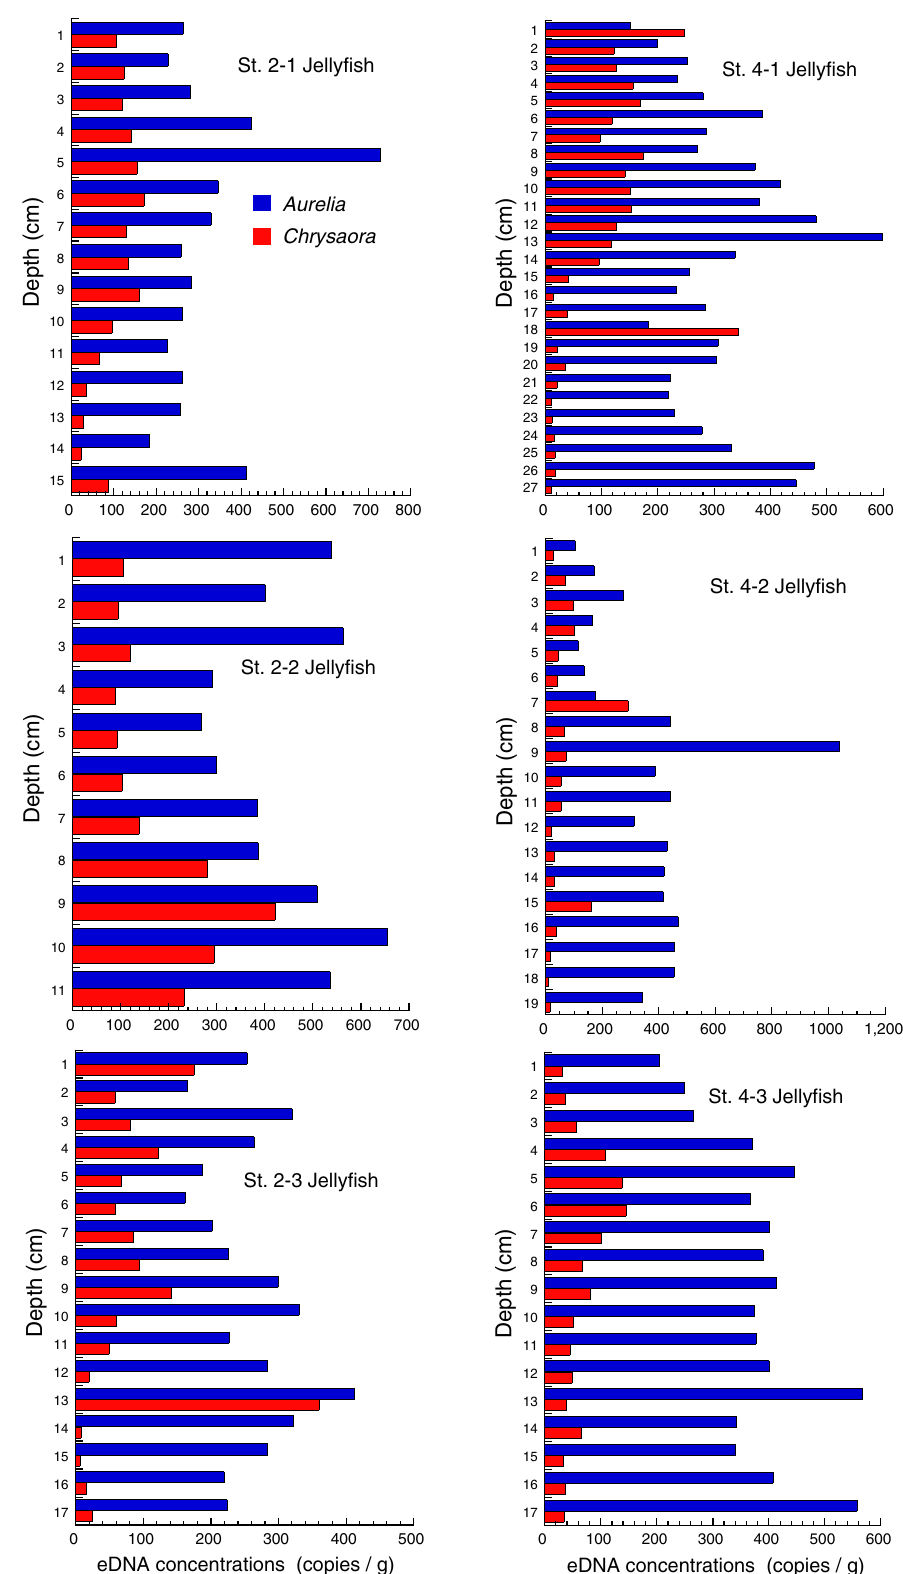
Figure 6. Concentrations of moon jellyfish ( Aurelia sp.) and sea nettle ( Chrysaora pacifica ) eDNA analyzed from samples of the sediment cores collected at St. 2 and St. 4 in Moune, Kesennuma, northeast Japan. Only eDNA was analyzed for these